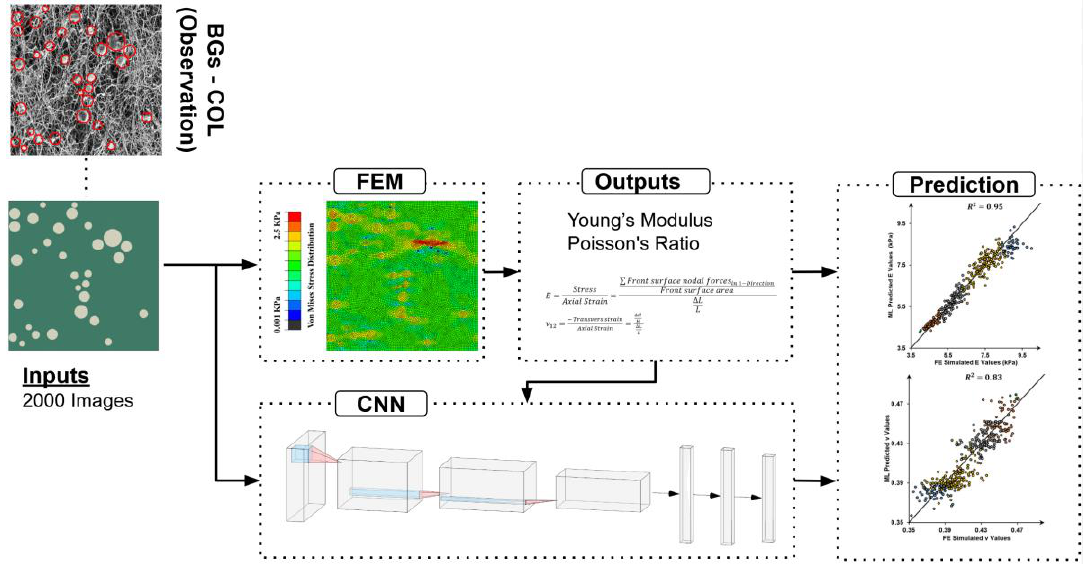
Figure 1. The overall framework combines FE analysis with an ML method to predict the mechanical properties of composite.